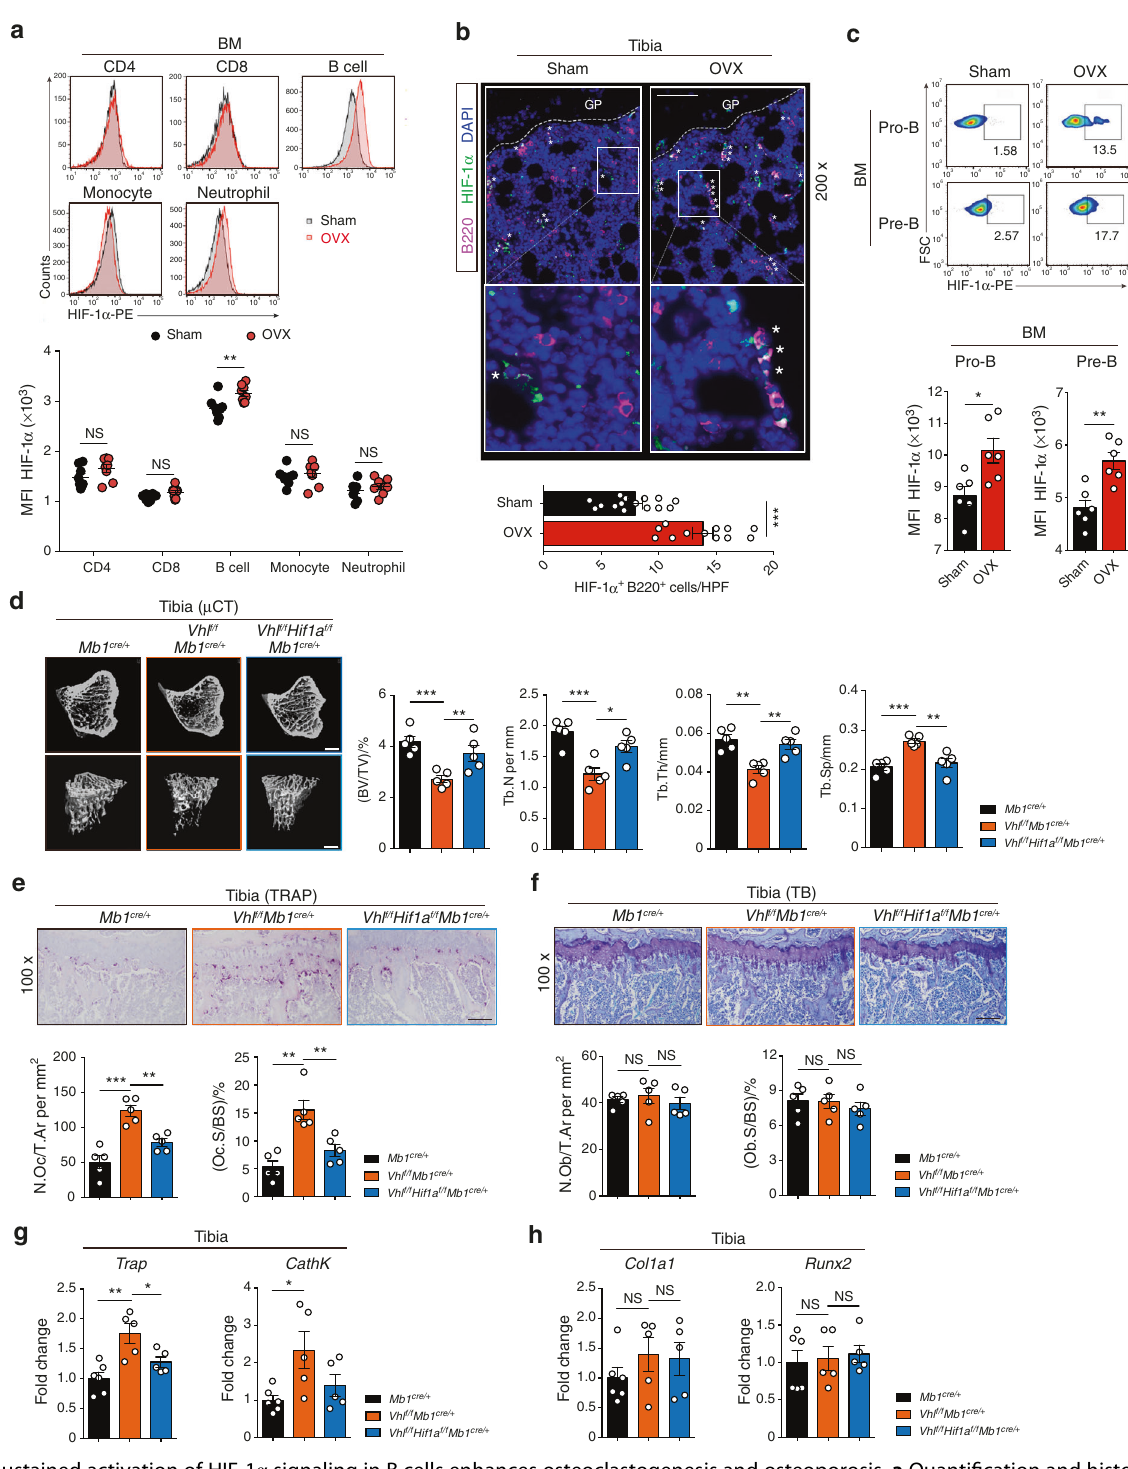
Fig. 1 Sustained activation of HIF-1 α signaling in B cells enhances osteoclastogenesis and osteoporosis. a Quanti fi cation and histograms of HIF-1 α expression in CD4 T cells, CD8 T cells, B cells, monocytes and neutrophils from the bone marrow of sham-operated (Sham) and ovariectomized (OVX) mice ( n = 8). b Representative immuno fl uorescence microscopy images of tibial sections from Sham and OVX mice (HIF-1 α , green; B220, purple), along with the average number of HIF-1 α + B220 + B cells per high-power fi eld (HPF). Asterisks indicate HIF- 1 α + B220 + B cells in the bone niche. GP growth plate. Scale bars, 50 μ m. c Representative plots and quanti fi cation of HIF-1 α expression in Pro-B and Pre-B populations from Sham and OVX mice ( n = 6). d Representative μ CT images of tibial trabecular bone and structural parameters (BV/TV, Tb.N, Tb.Th, Tb.Sp) in Mb1 cre/ + , Vhl f/f Mb1 cre/ + and Vhl f/f Hif1a f/f Mb1 cre/ + mice ( n = 5). Scale bars, 500 μ m. Representative TRAP staining ( e ) and TB staining ( f ) in tibias from mice shown in ( d ). Bone resorption parameters (N.Oc/T.Ar, Oc.S/BS) and bone formation parameters (N.Ob/T.Ar, Ob.S/BS) in metaphyseal regions of the tibia were assessed by histomorphometric analyses. Scale bars, 100 μ m. Trap , CathK ( g ), Col1a1 and Runx2 ( h ) expression in bone from mice shown in ( d ). Values for control group were set as 1. * P < 0.05, ** P < 0.01, *** P <